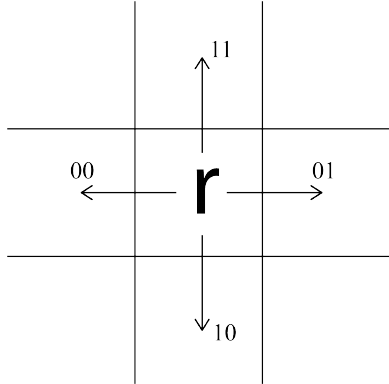
Figure 14. Encoded moves within a generic map ( n ≥